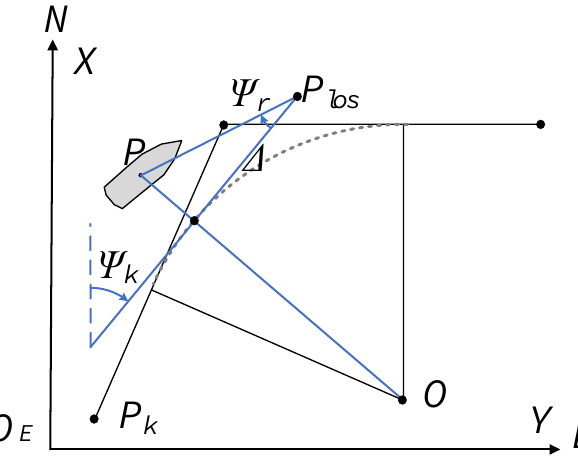
Figure 5. Arc LOS guidance law diagram.